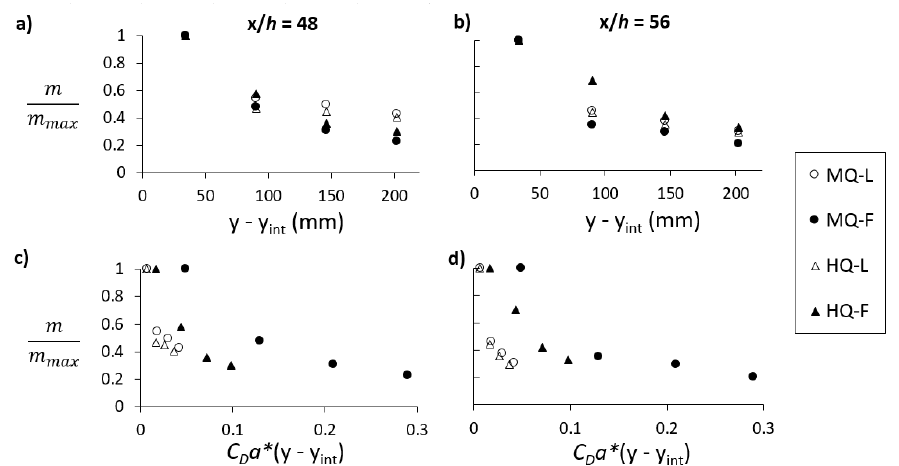
Figure 8. Lateral profiles of net deposition per unit area m for two longitudinal positions at ( a ) x/ h = 48 and ( b ) x/ h = 56 in the fully developed region of the flow ( x > L T ), normalized with the maximum m max over the lateral profile. Plots ( c ) and ( d ) show the lateral pattern of net deposition over the distance from the interface ( y – y int ) scaled with the drag density parameter C D a . MQ = medium flow rate (50 L/s); HQ = high flow rate (83 L/s); L = leafless; F = foliated.